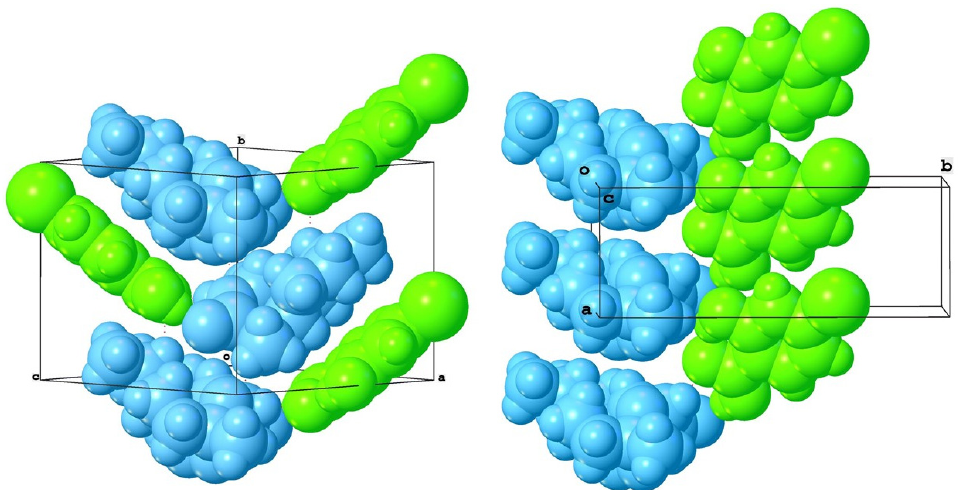
Figure 8. Two fold screw and translational molecular pair stacks in 2a and 2b respectively, showing